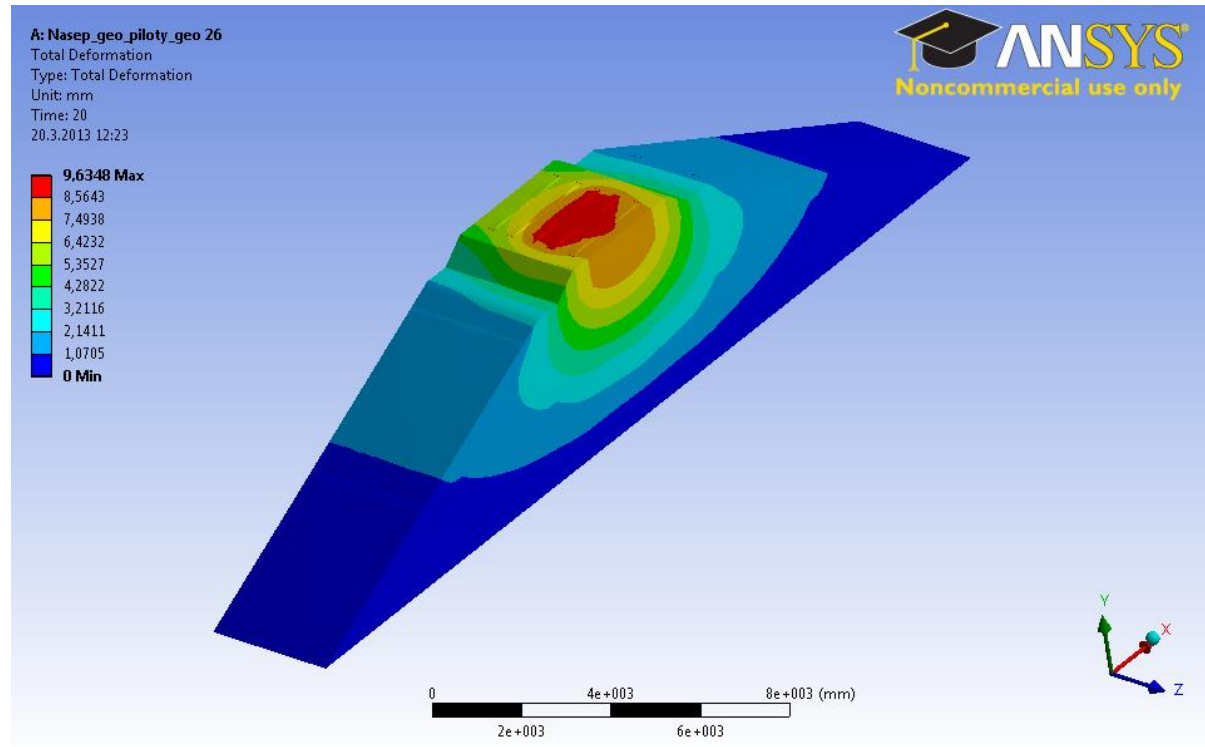
Figure 12. Total deformation of the embankment with the geogrid andthe columns sheathed a